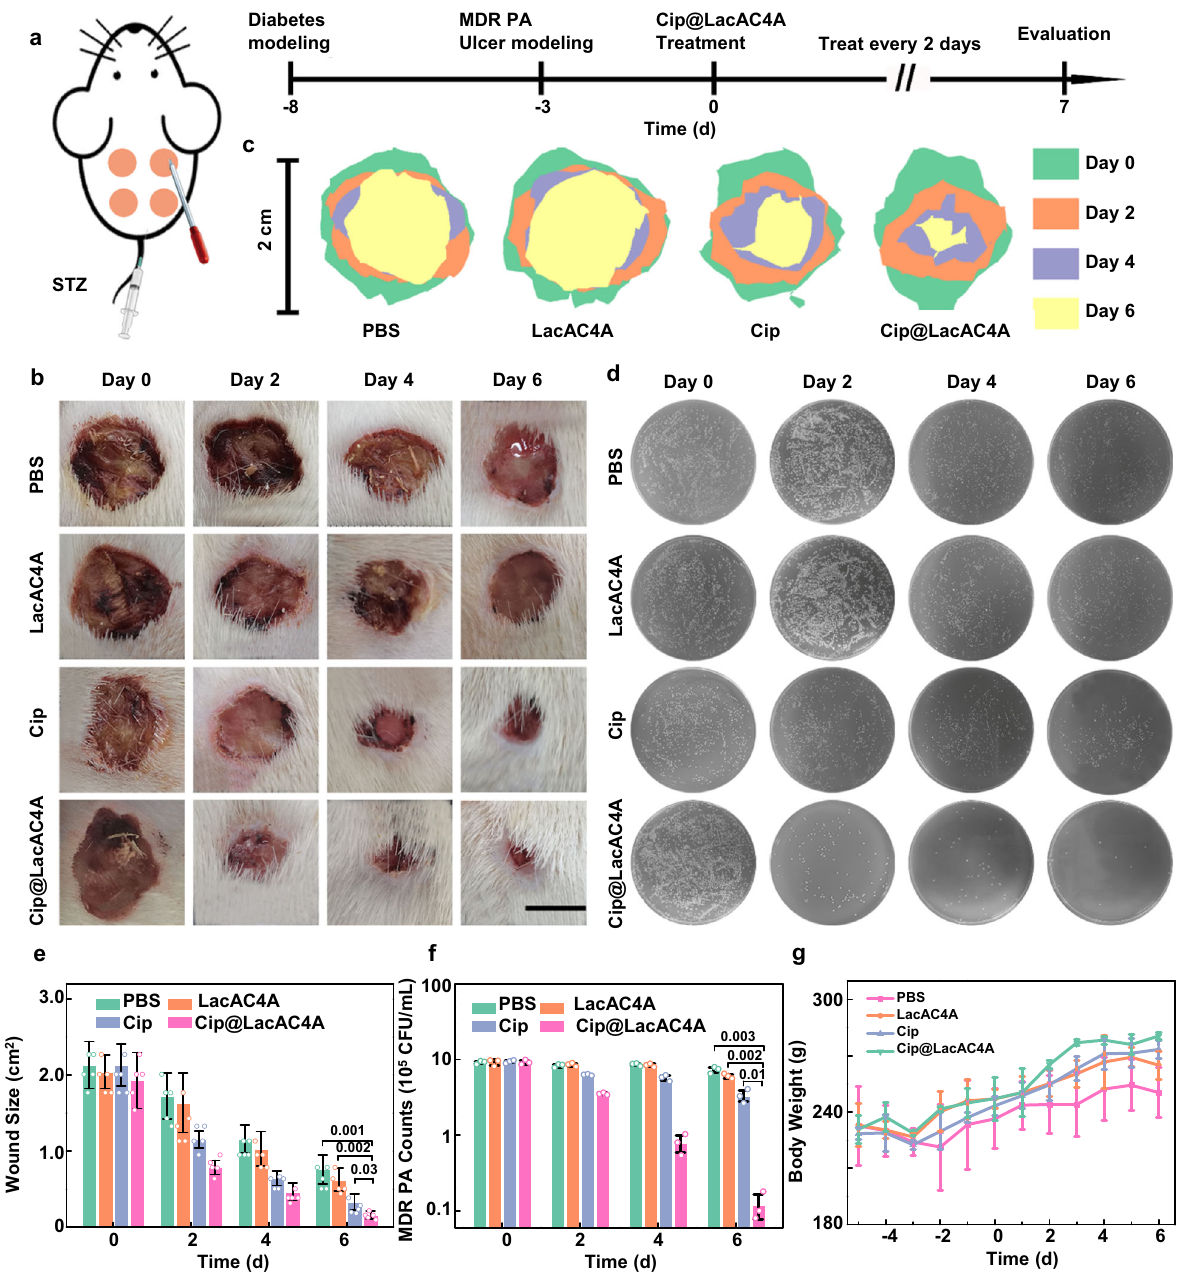
Fig. 6 | The ability of LacAC4Ato promote wound healing infected by MDR PA in vivo. a Scheme of the therapeutic process of MDR PA-infected diabetic wound healing. b Representative images of wound change in diabetic rats infected with MDR PA after treatments. Scale bar was 1.0cm. c Traces of wound-bed closure in diabeticratsinfectedwithMDRPAaftertreatments. d WoundareachangesinMDR angiogenesis (Fig. 7e). The green fl uorescence representing CD31